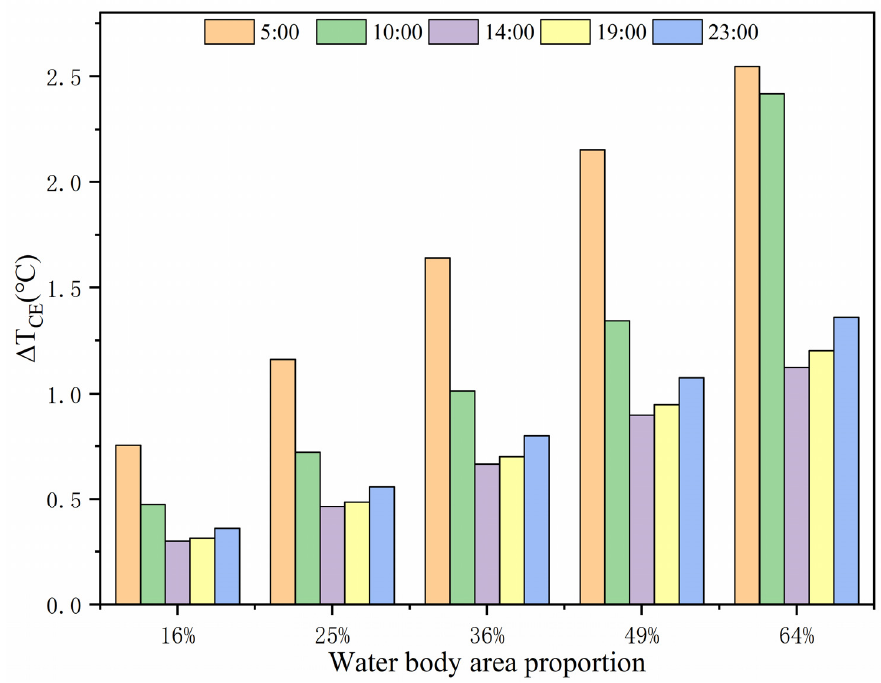
Figure 4. The cooling effect of water bodies with different area proportions at different time points.